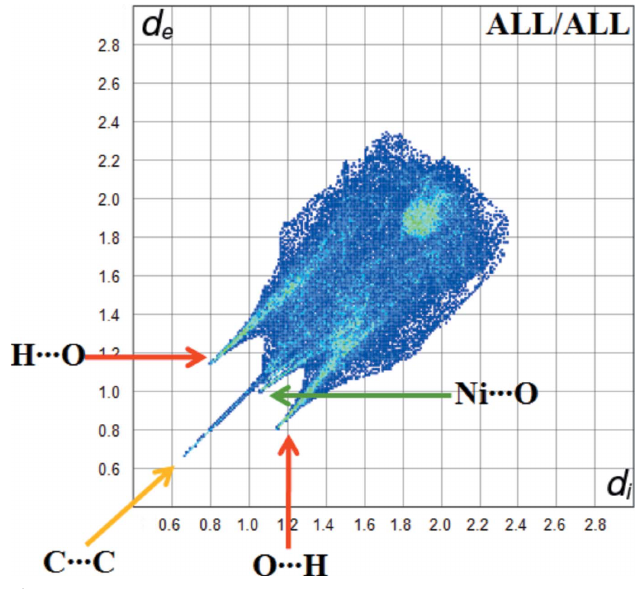
Figure 5 A fingerprint plot of the title